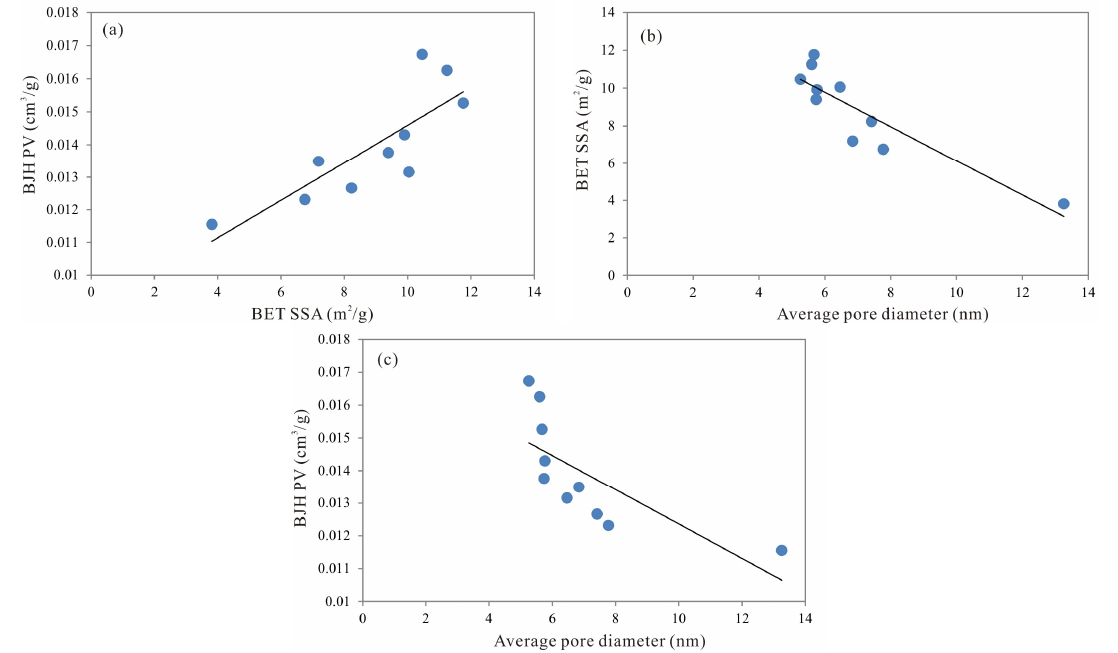
Figure 10. ( a ) Relationship between SSA and PV and ( b ) relationships between average pore diameter and PV, ( c ) SSA.